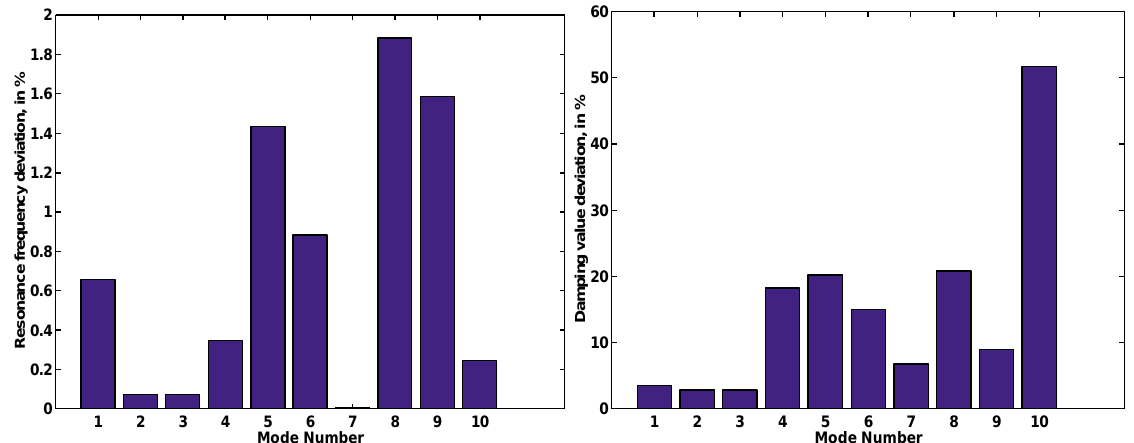
Fig. 3. Relative change of resonance frequencies (left) and relative change of damping values (right) between damaged and undamaged states of a cracked plate. The estimates are computed using the classical LSCE estimator.